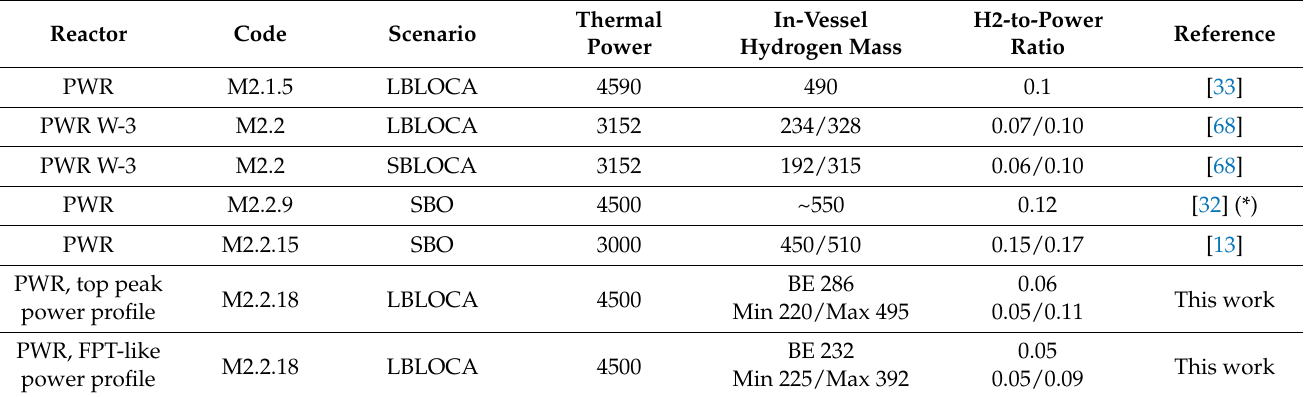
Figure 9. Hydrogen generation for FPT-1. Best estimate case (black line), mean value (blue line) based on interpolation and extrapolation for both fully and partially successful cases, fully success- ful cases (grey lines), and partially successful cases (red lines). Partially successful are cases that converged after the time limit of 16,500 s (340 cases). Box-charts are presented with the central bar being the median value for FoM, while the lower and upper quartiles are presented by a blue box, and minimum and maximum values that are not outliers are presented by black whiskers and out- liers with blue circles. For PWR cases (Figure 8), the first that can be observed was the significant impact of the power profile, and the relative difference between medians, for both models, was ~25% (~69 kg), which was similar to the difference observed for BE cases (Figure 7). For the PWR with an FPT-like profile, the final mean was 279 kg, and the median was 277 kg with lower and upper quartiles in the range of 257–299 kg and whiskers in the range of 225–360 kg. The best estimate result equal to 232 kg was below the two-quartile region and substantially below the median. Outliers were observed only for the upper values with the highest value of 392 kg, and the lowest observed value was 225 kg. In the case with a top-peaked power profile, the final mean and median were 348 kg and 346 kg, respectively. The quartile box (upper and lower quartiles around the median) was in range of 319–374 kg and the whiskers were in the range of 237–457 kg. The best estimate